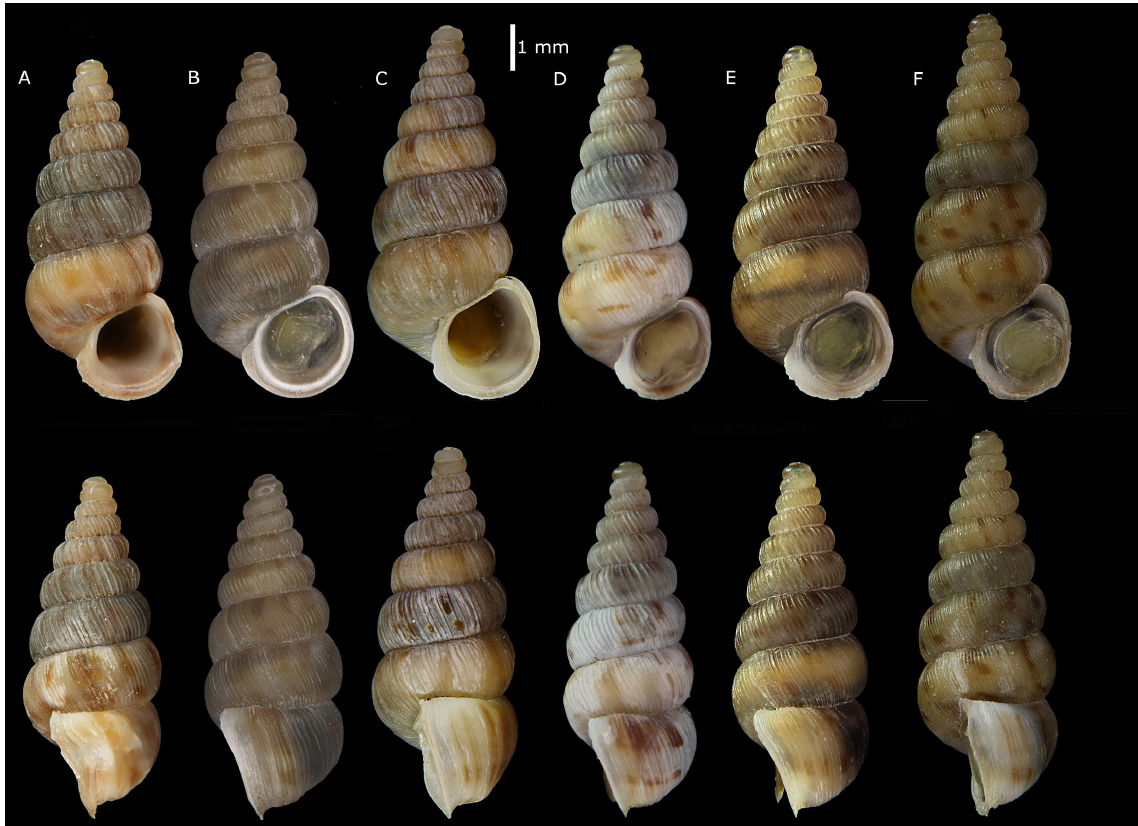
Fig. 22. Shell variability in Cochlostoma ( Clessiniella ) anomphale Boeckel, 1939. A . Savinjska Dolina, Slovenia (WdM1579). B . Eisenkappel, Austria (EZ0034). C . Stahovika, Slovenia (EZ0035). D . Vellach, Austria (EZ0991). E . Solčava, Slovenia (WdM7010). F . Logarska Dolina, Slovenia